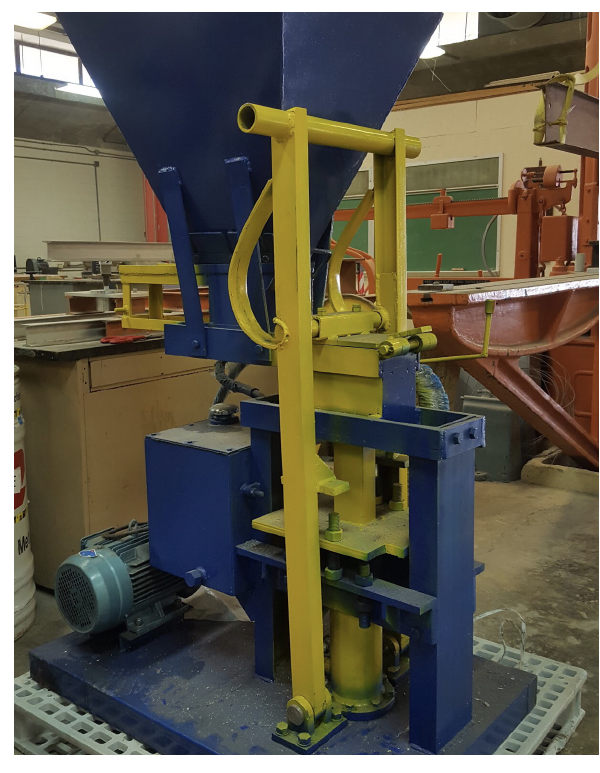
Figure 1: Eco Brava TM brick casting machine